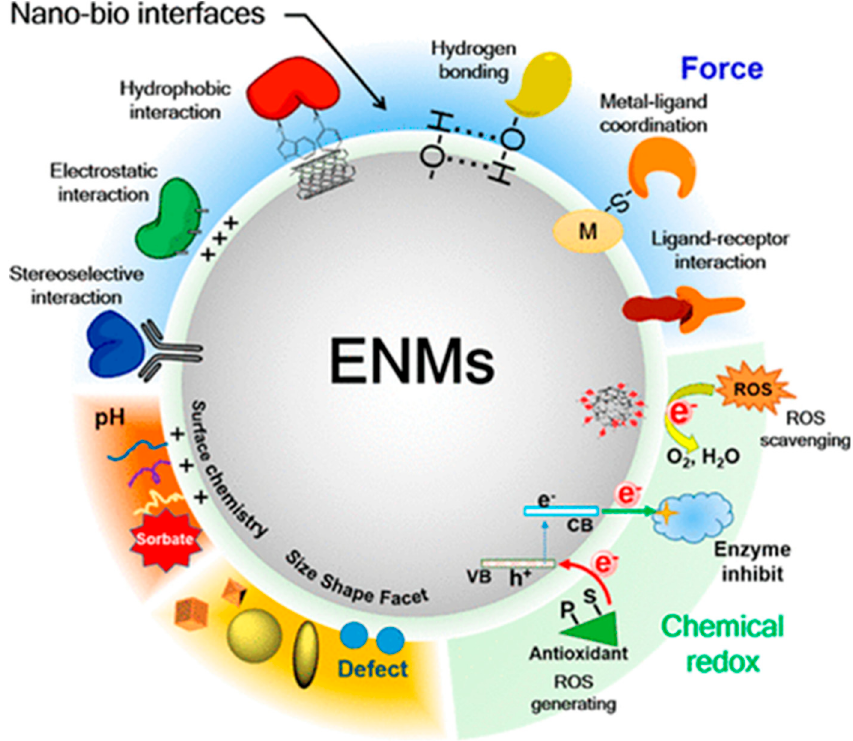
Figure 42. Main driving factors (i.e., CNDPs) at the nano–bio interface of a nanoparticle influencing development of nanomedcines. Reproduced with permission from [182]. Copyright 2019 American Chemical Society.